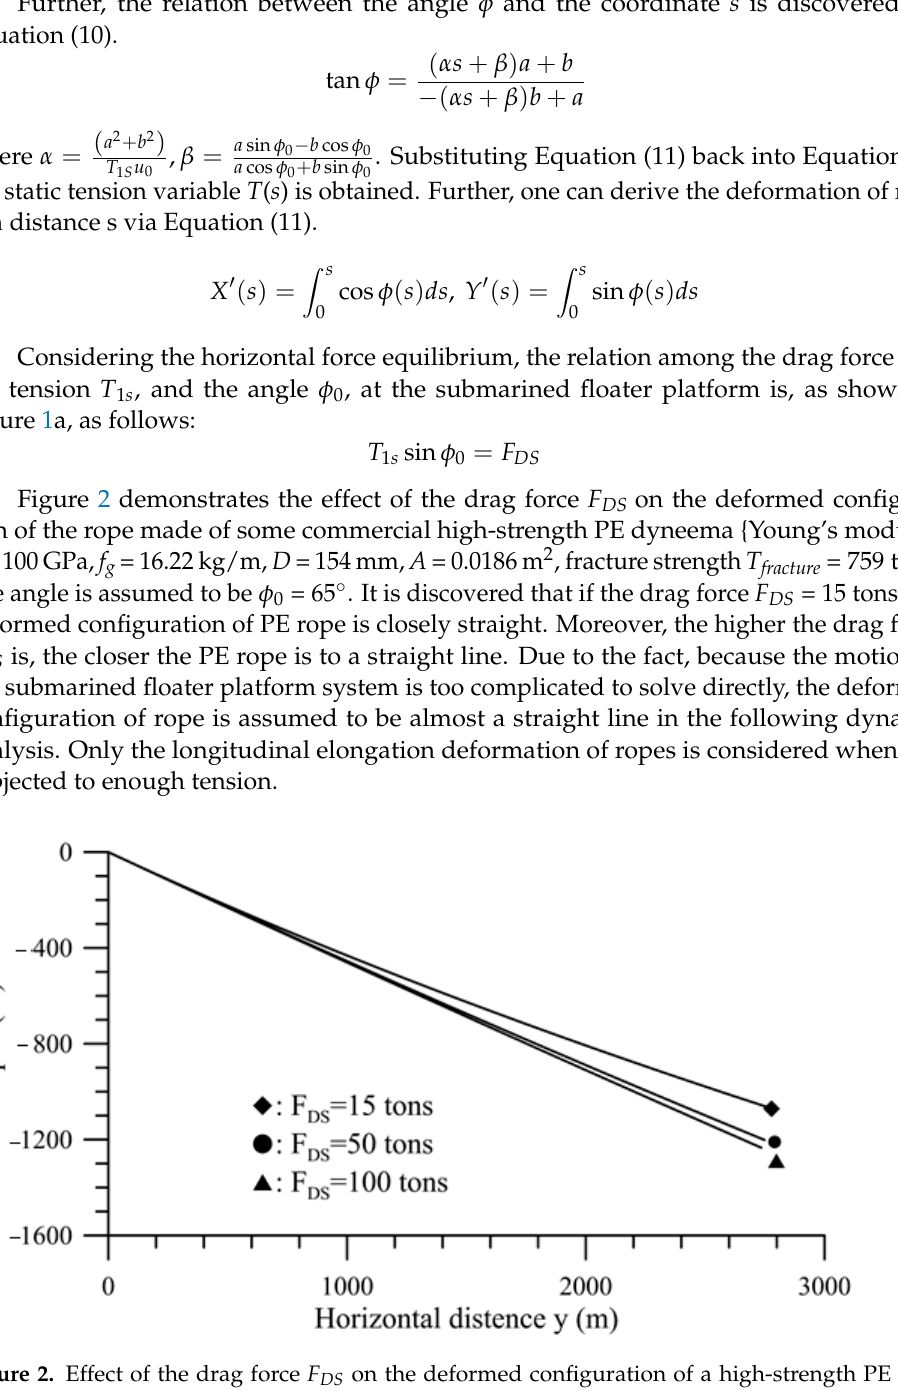
Figure 2. Effect of the drag force F DS on the deformed configuration of a high-strength PE rope [ 0 =65 φ , f g = 16.22 kg/m, D = 154 mm, A = 0.0186 m 2 , f b = 182.28 N/m, C D = C L = 0.3, V = 1 0